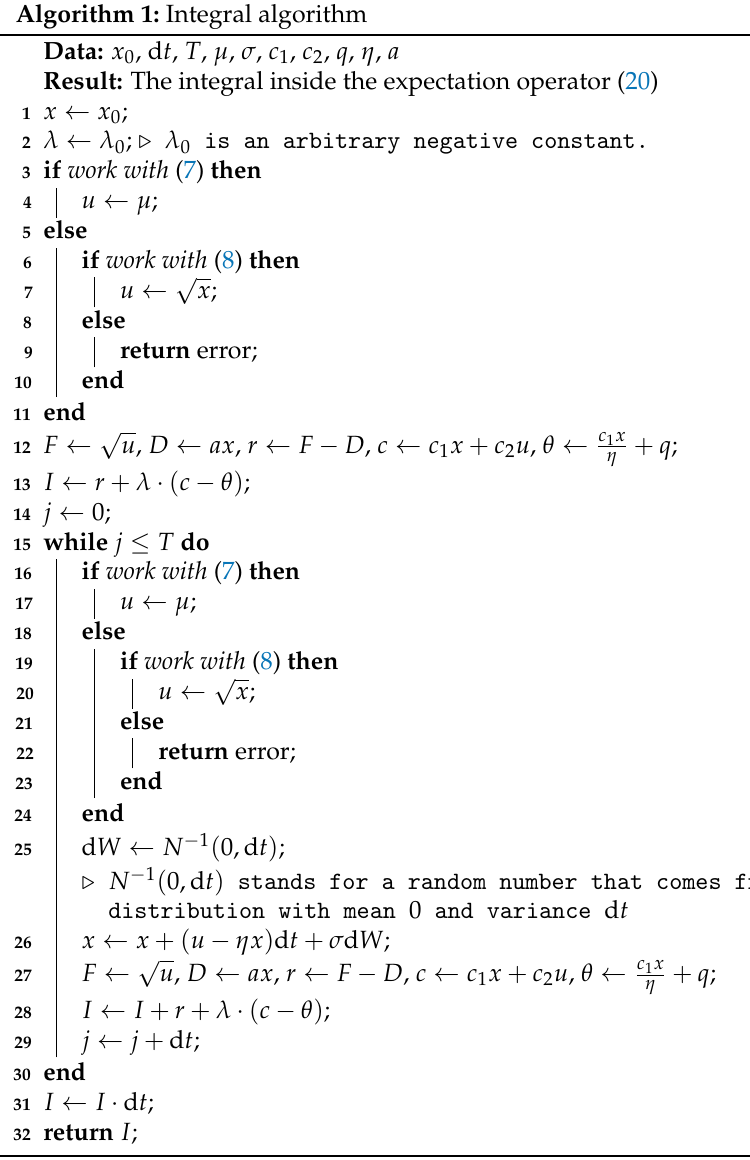
Algorithm 1: Integral